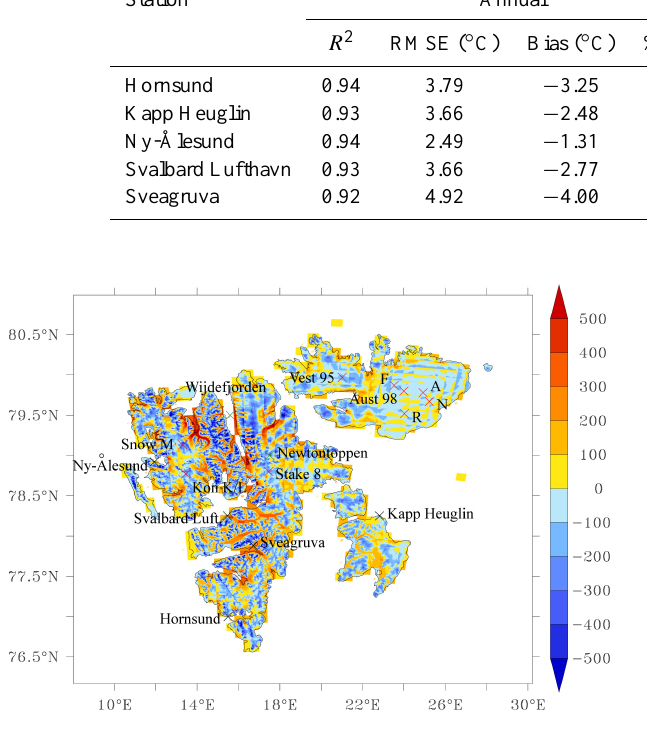
Figure 2. Elevation difference (m) between the 10km MAR topog- raphy (based on the topography of the Norsk Polarinstitutt – NPI) and the topography of the NPI interpolated on a 250m grid. The black X show the location of the weather stations used in the vali- dation and the red ones show the location of the stakes from Pinglot et al. (1999,